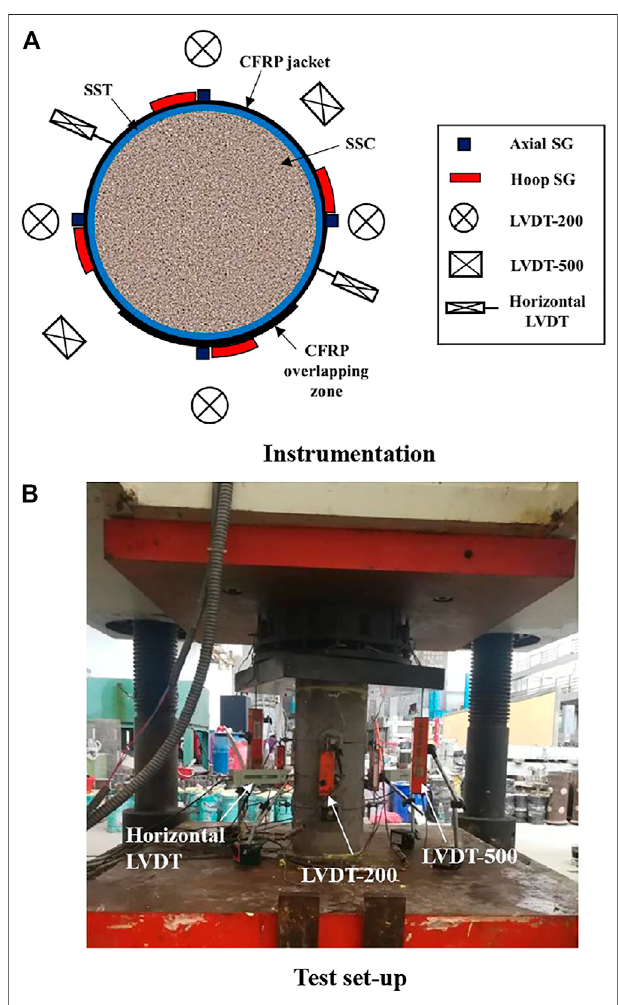
FIGURE 3 | Instrumentation and test setup. (A) Instrumentation. (B) Test